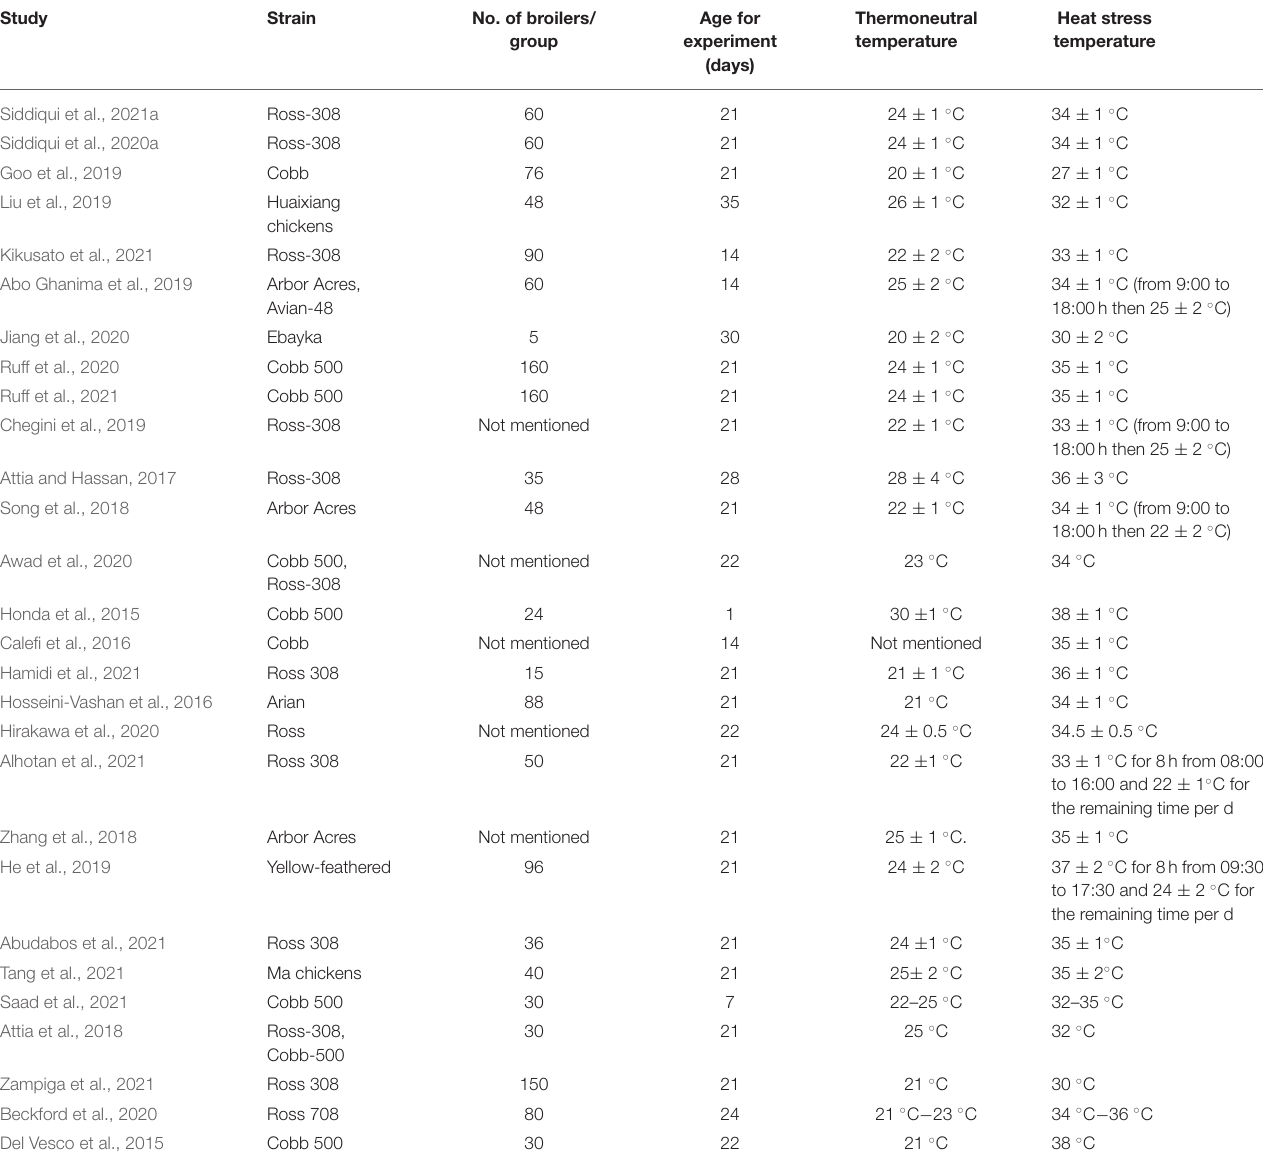
TABLE 1 | Characteristics of all selected